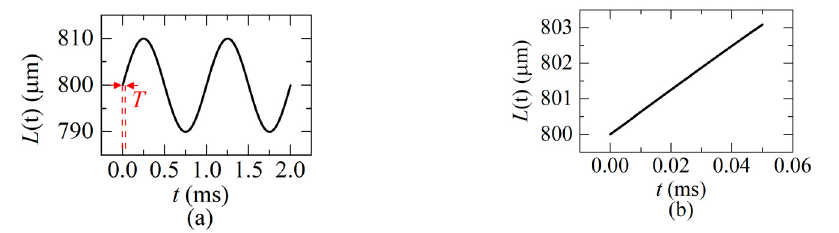
Figure 9. ( a ) A dynamic distance varies as a sinusoidal function ( L (0) = 800 μ m, ω = 1 KHz, A = ±10 μ m, v max = 0.06 m/s); ( b ) the distance in a sweeping cycle ( f sweep = 20 KHz).